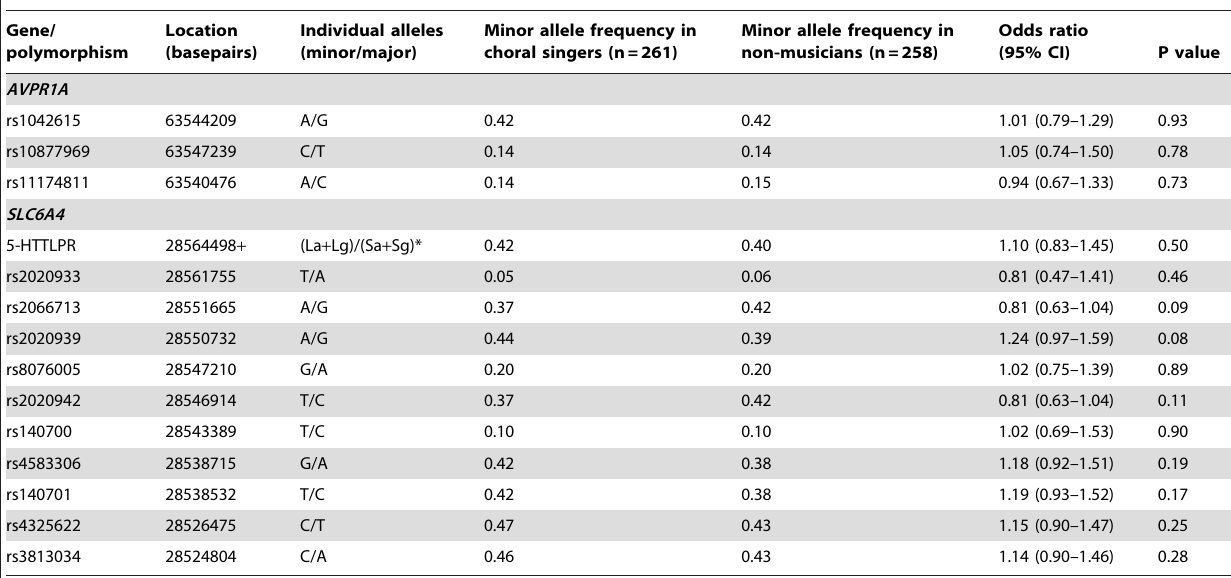
Table 2. Association of AVPR1A and SLC6A4 SNPs, and 5 -HTTLPR, with singer/non-musician status.